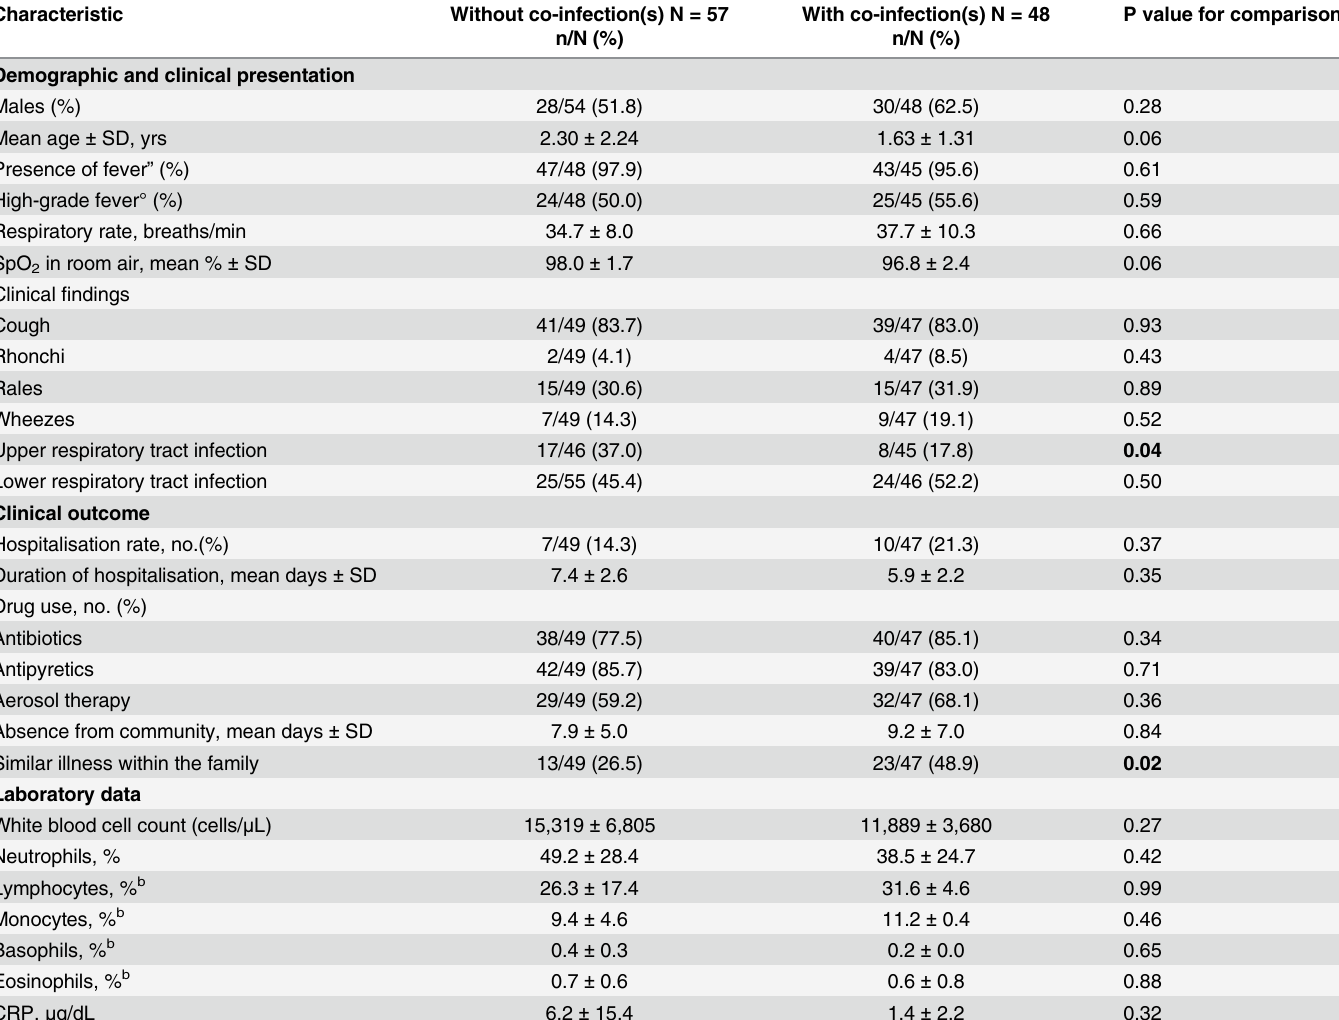
Table 4. Comparisons between subjects positive for human bocavirus with or without co-infection(s), according to demographic, clinical and lab- oratory variables. a Characteristic Without co-infection(s) N = 57 With co-infection(s) N = 48 P value for comparison n/N (%) n/N (%) Demographic and clinical